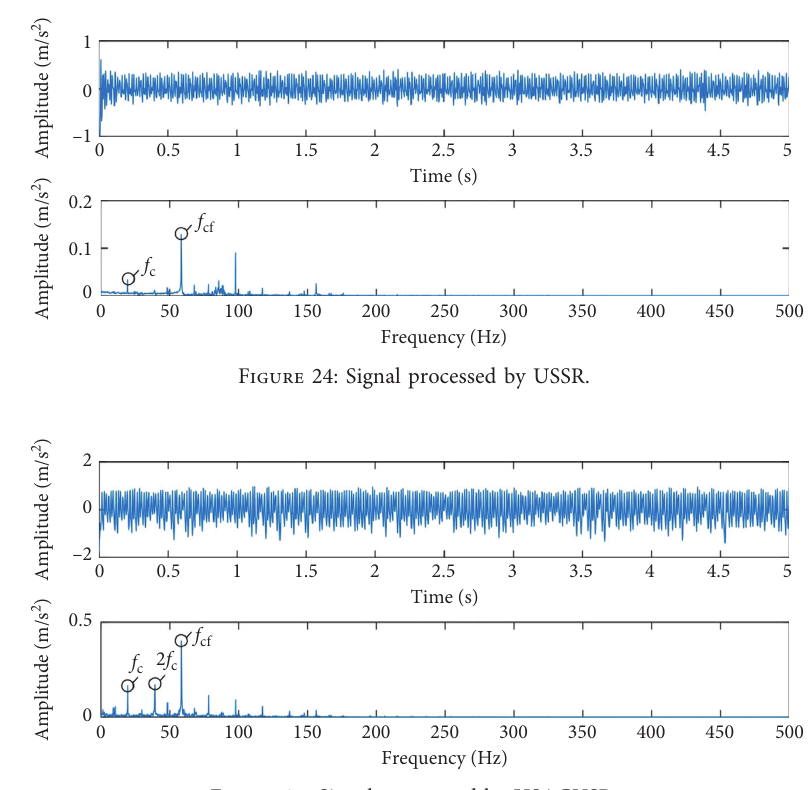
Figure 25: Signals processed by